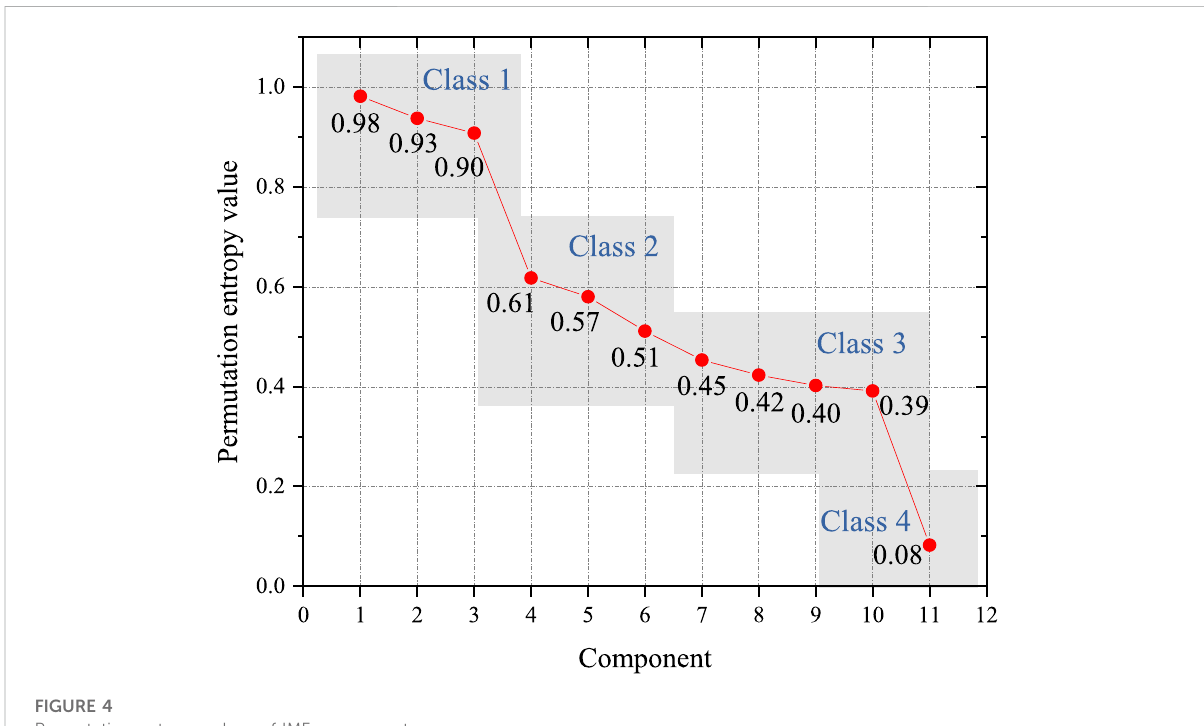
FIGURE 4 Permutation entropy values of IMF components.